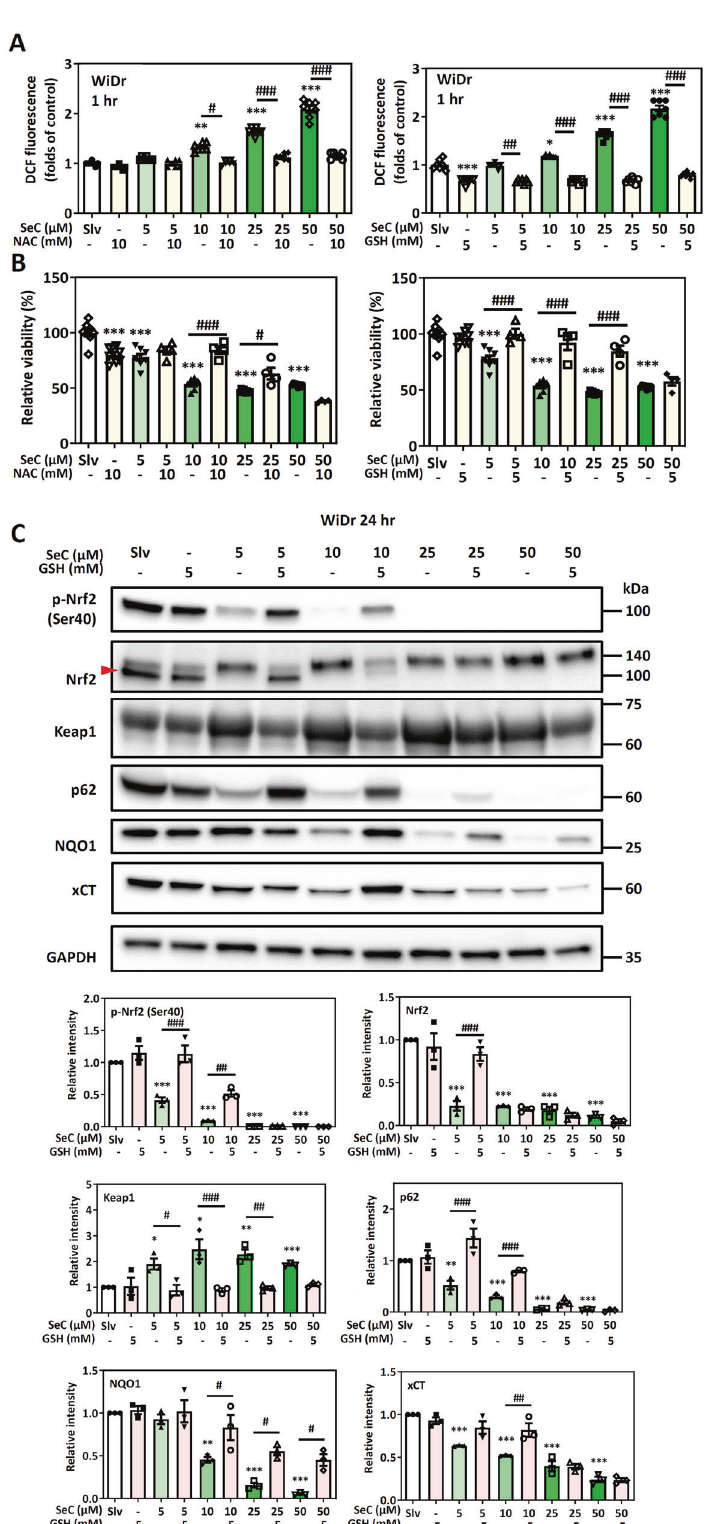
Fig. 4 Effects of antioxidants on SeC-induced cell death and the Nrf2 pathway. A Intracellular ROS levels ( n = 7) were measures by fl uorescent reader after SeC treatment with or without antioxidants (NAC and GSH). B cell viability ( n = 8) of WiDr cells exposed to SeC with or without antioxidants (NAC and GSH) pretreatment. The values were presented as average ± SD from seven or eirht independent repeats. C Levels of phosphorylated Nrf2 and Nrf2 regulated proteins in WiDr cells after SeC treatment and GSH. GAPDH was used as loading control ( n = 3) (* P < 0.05, ** P < 0.01, *** P < 0.001, compared with solvent control, ## P < 0.01, ### P < 0.001, compared with SeC-treated cells without antioxidant pretreatment, signi fi cance was determined by one-way ANOVA). The values were presented as average ± SD from three independent